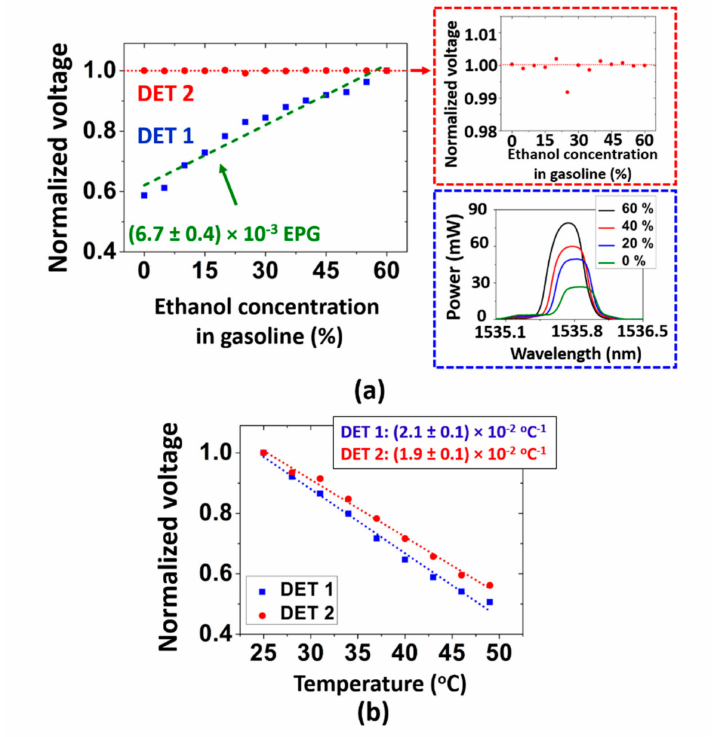
Figure 3. ( a ) Normalized voltage measured in the photodetectors (DET 1 and DET 2) as a function of the ethanol concentration in gasoline. Inset shows the signal measured by OSA 1 as a function of the ethanol concentration. ( b ) Normalized voltage variation measured in the photodetectors (DET 1 and DET 2) as a function of the